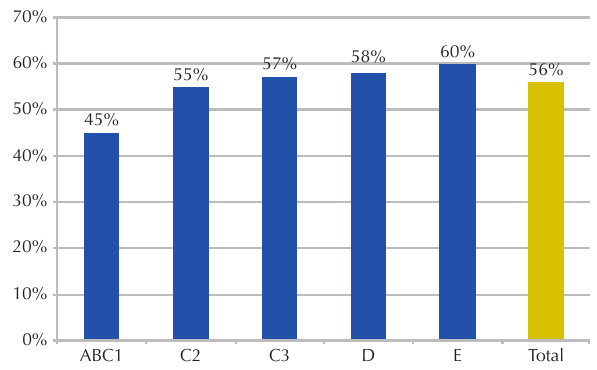
Table 1: Number of fitness equipment per outdoor gym. Source: own